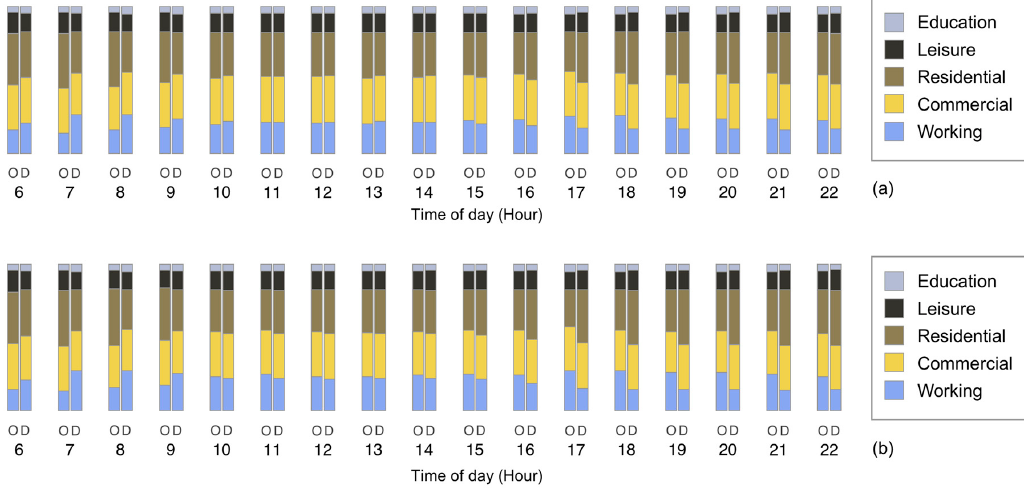
Figure 7. The proportions of origin and destination associated with different land uses during weekdays for ( a ) all travellers and ( b ) commuters.